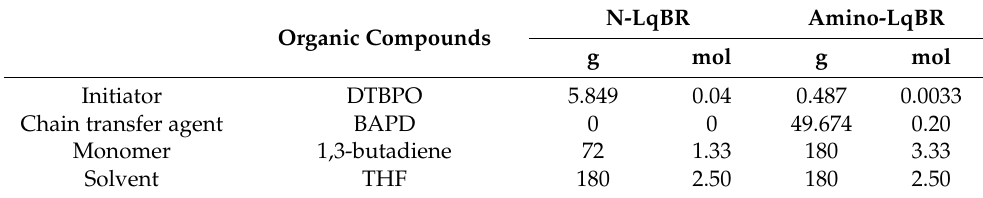
Table 1. Formulation for the polymerization of LqBRs (Unit: g,